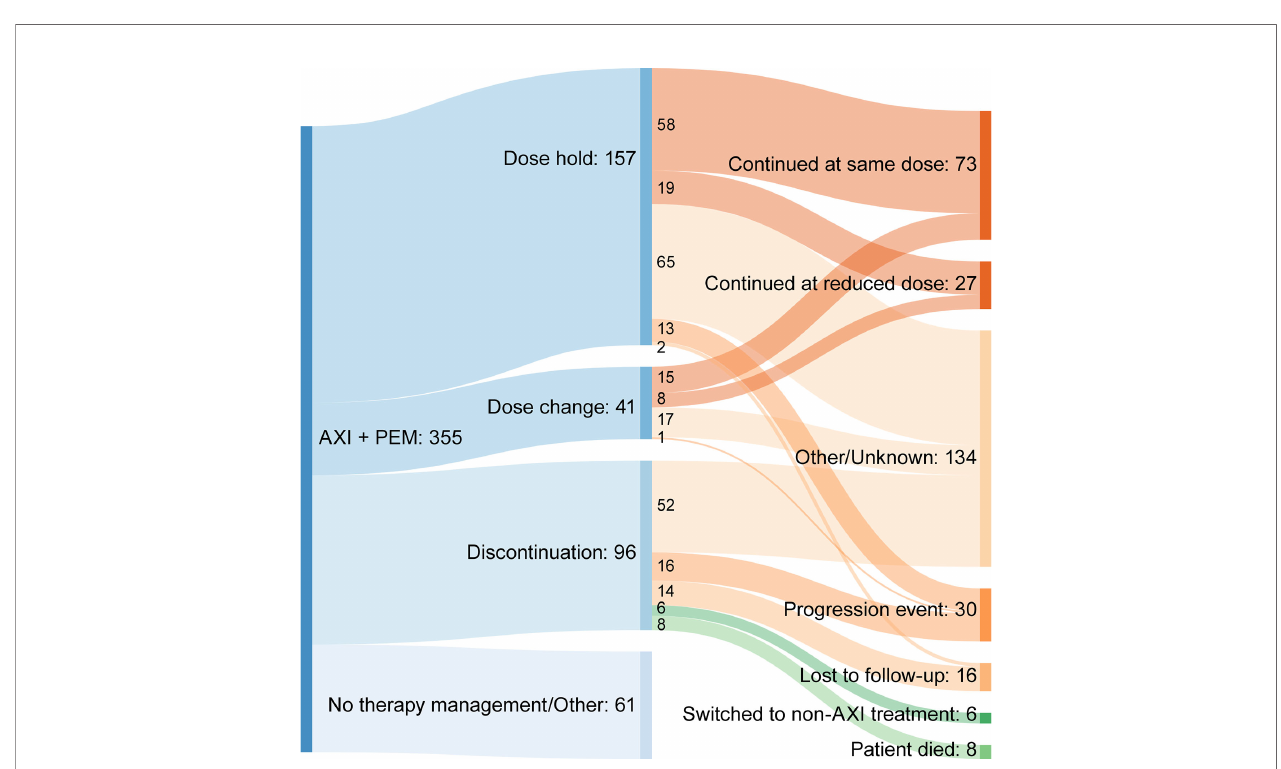
FIGURE 4 | Sankey diagram summarizing subsequent events following therapy management due to toxicity. AXI + PEM, axitinib plus